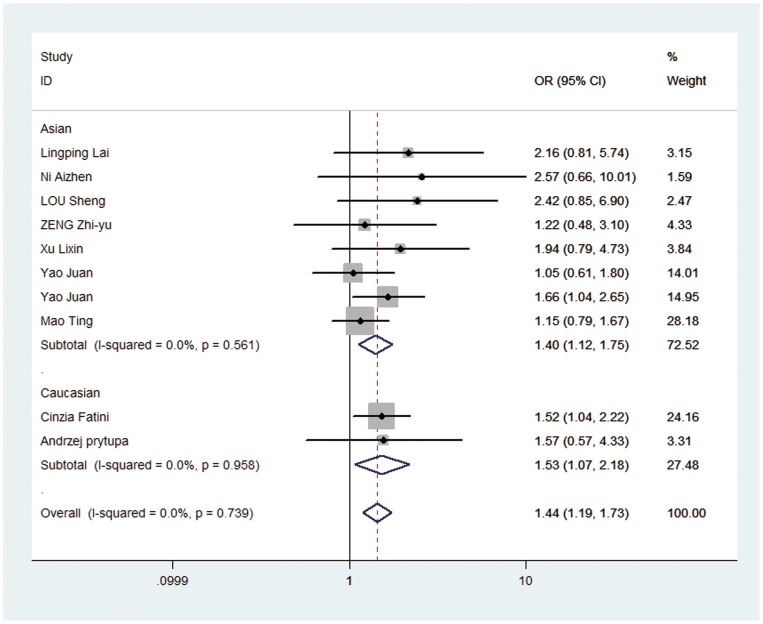
Forest plot of heterozygous comparison (GA vs. AA) for overall comparison in fixed-effects model.(OR = 1.436, 95%CI: 1.190, 1.732; Pheterogeneity = 0.739).